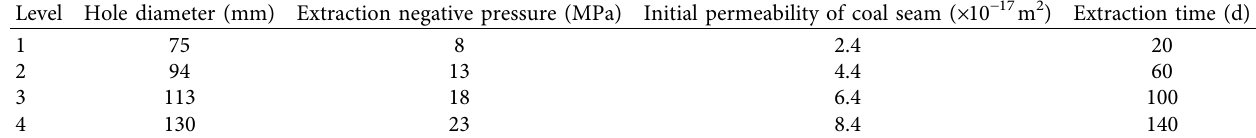
Table 3: Level values of each